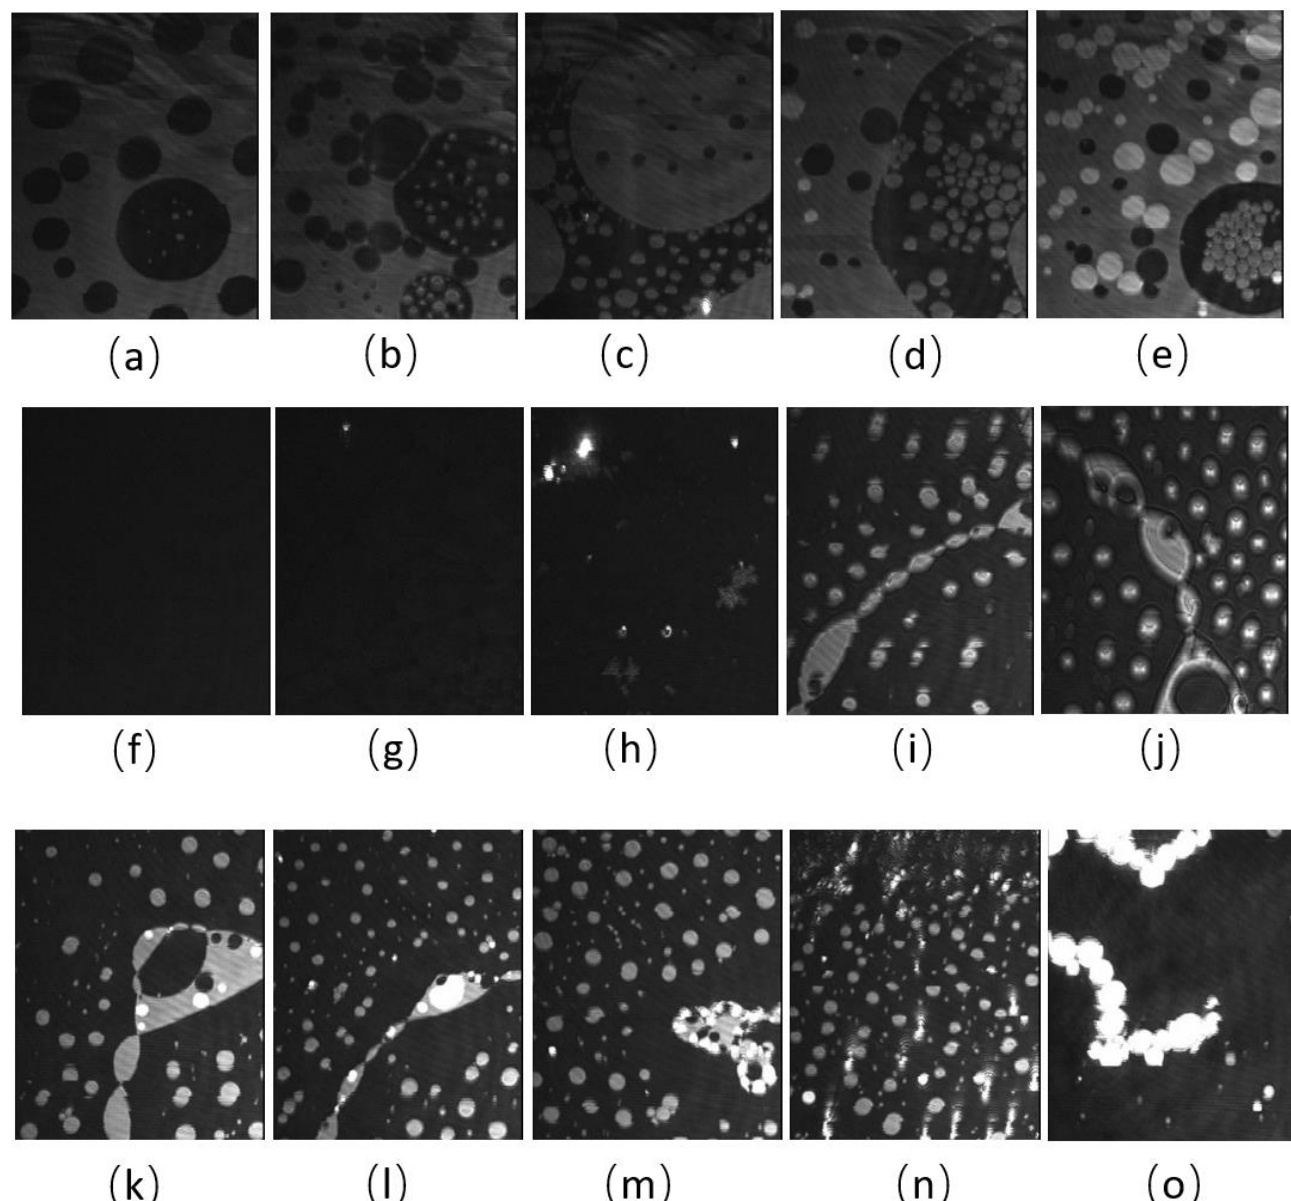
Figure 3. ( a - j ) BAM images (220 µm wide) of CO:PC 90:10 (binary mixture) film before ozone exposure ( a – e ) and after ozone exposure ( f – j ) at surface pressures of 2 mNm -1 , 5 mNm -1 , 7 mNm -1 , 13 mNm -1 and 14 mNm -1 on PBS at 22 °C. ( k – o ) BAM images (220 µm wide) of CO:PC 90:10 (binary mixture) film after ozone exposure at surface pressures of 16 mNm -1 , 18 mNm -1 , 19 mNm -1 , 23 mNm -1 and 20 mNm -1 on PBS at 22 °C (the last image was taken as the pressure decreases after compression is stopped). The BAM images of CO:GT:PC 40:40:20 (ternary mixture) (Figure 4) also show fluid-